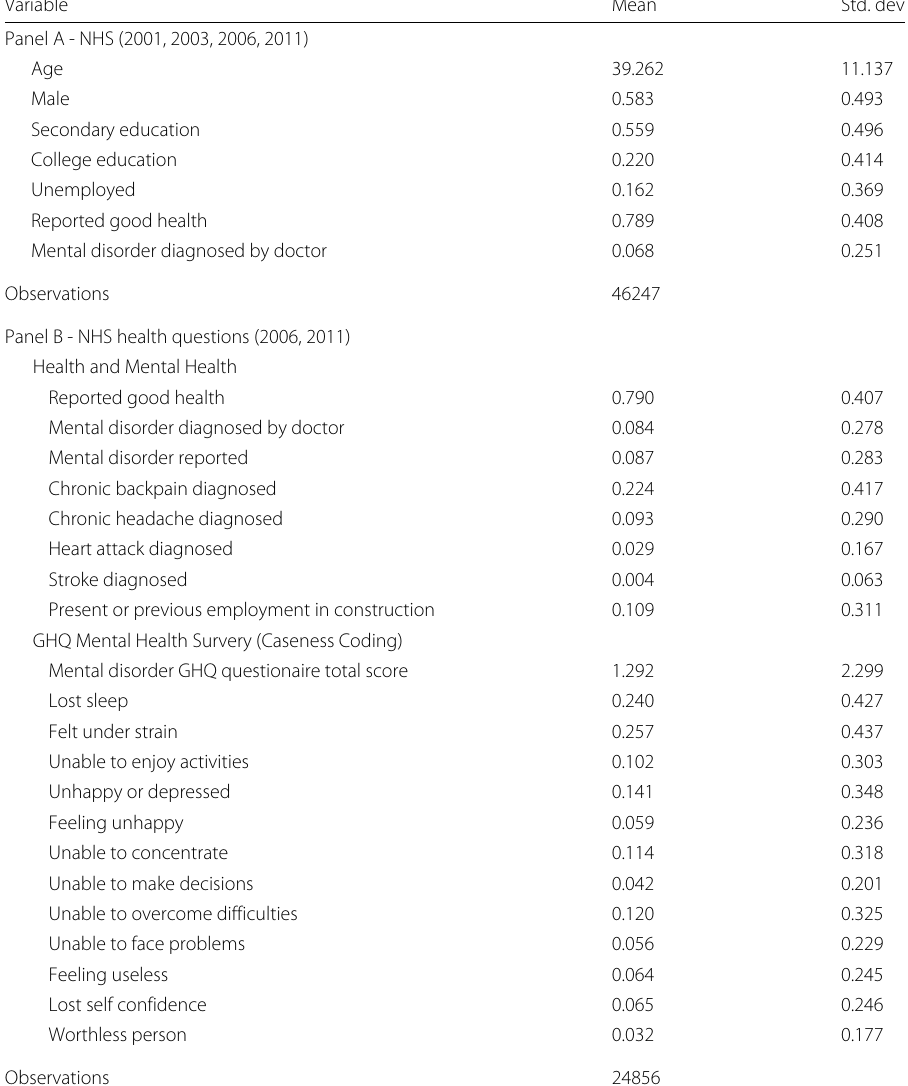
Table 1 Summary